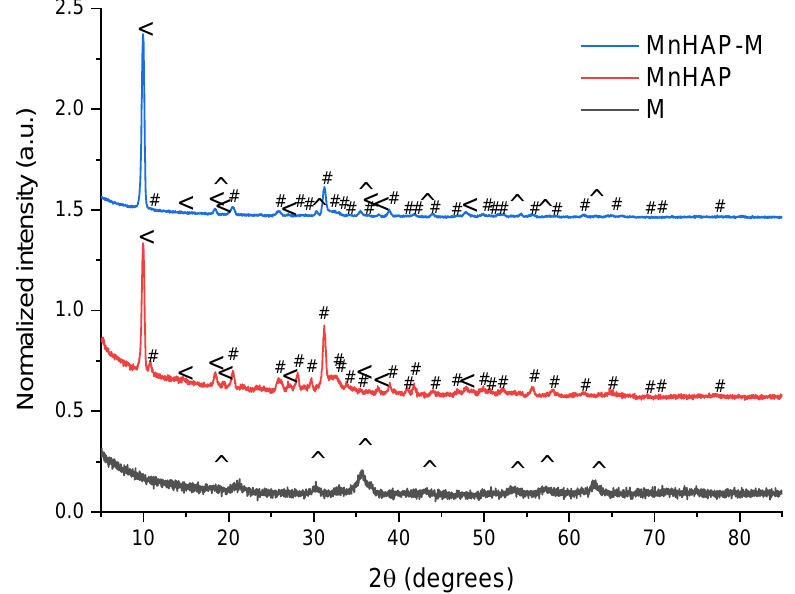
Figure 2. X-ray di ff ractograms of the analyzed materials. #—peaks corresponding to the manganese Figure 2. X-ray diffractograms of the analyzed materials. # — peaks corresponding to the manganese apatitic material; < —pararobertsite; ˆ—iron oxide (magnetite / apatitic material; < — pararobertsite; ^ — iron oxide (magnetite/maghemite).